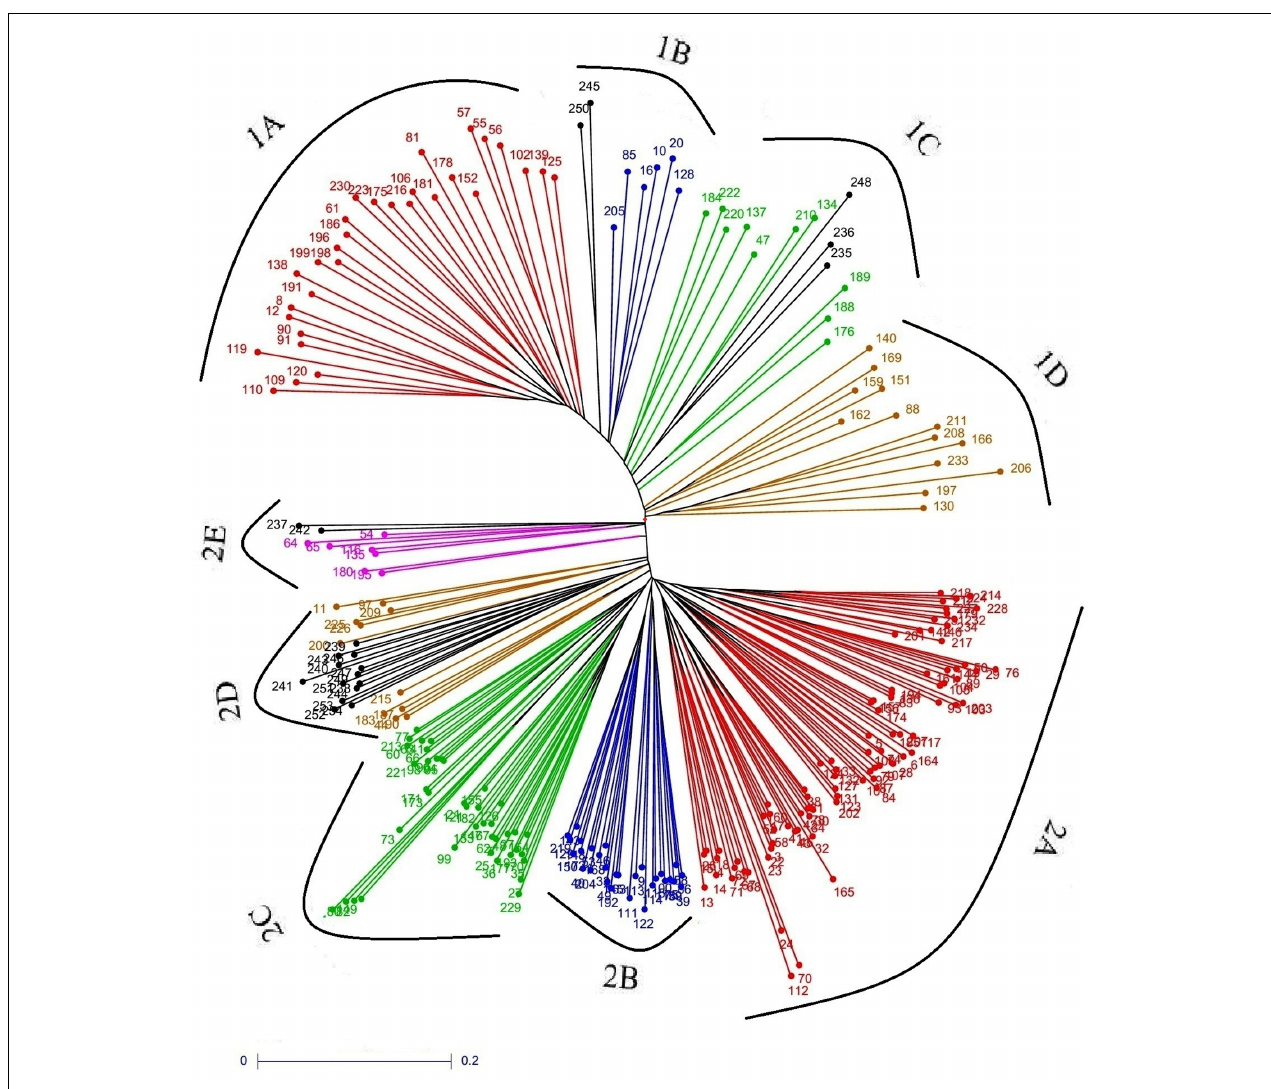
FIGURE 4 | Unweighted neighbor-joining tree of landraces grouped into two major clusters representing the genetic relationship among the